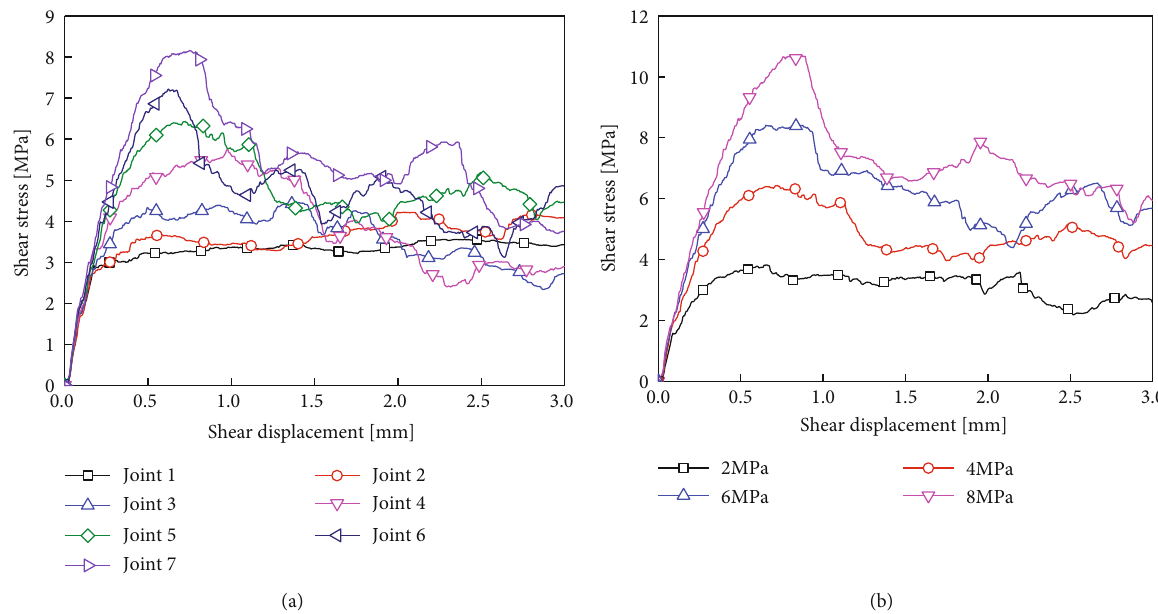
Figure 6: Shear stresses-shear displacement curves of joint samples: (a) in fl uence of roughness at normal stress of 4MPa; (b) in fl uence of normal stresses based on joint 7. Table 3: Shear strength values of joint samples (unit: